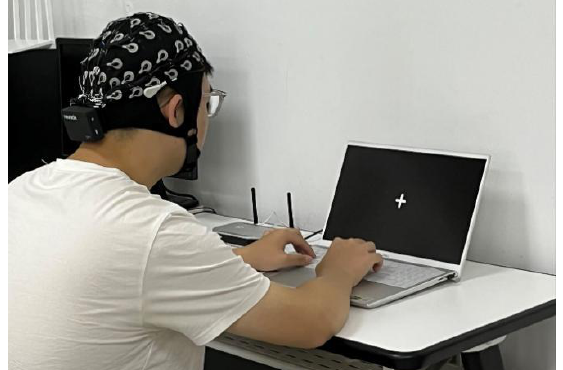
Figure 4. Experimental scenario.